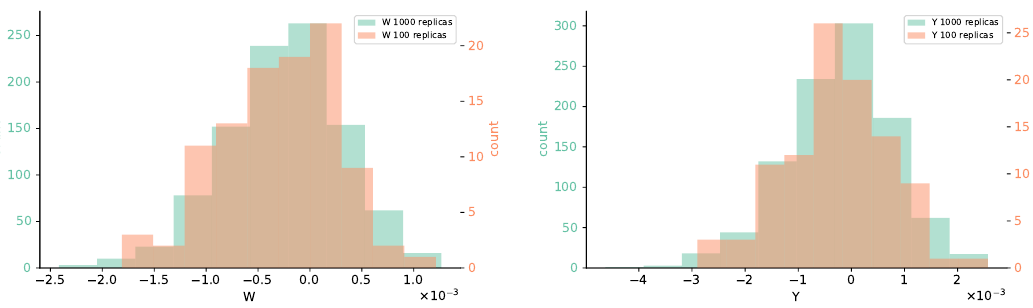
Figure 18 . Distributions of the best fit W (left) and Y (right) parameters using both high ( N rep = 1000 ) and low ( N rep = 100 ) statistics fits. We bring the readers attention to the different y axes for the histogram